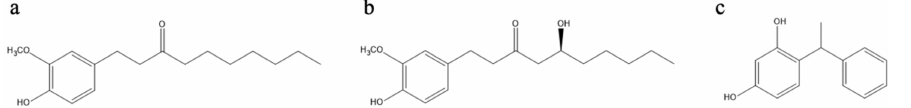
Figure 1. Structure of: ( a ) paradol-6; ( b ) main component of the ginger CO 2 extract; and ( c ) phenylethyl